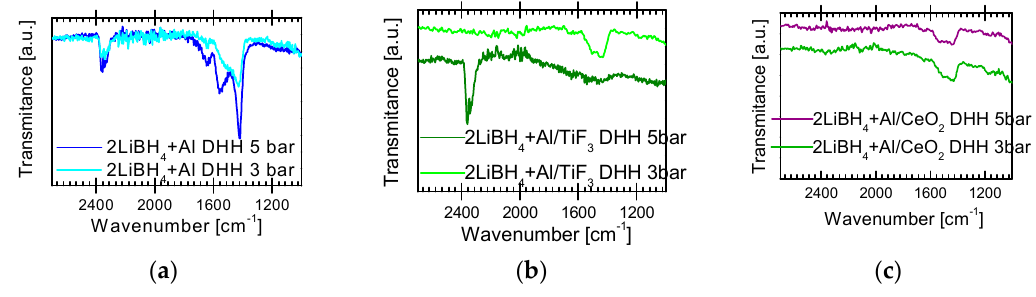
Figure 7. Fourier Transformed Infrared Spectroscopy (FT-IR) of dehydrogenated (DHH) samples: ( a ) 2LiBH 4 + Al-DHH; ( b ) 2LiBH 4 + Al/TiF 3 ; ( c ) 2LiBH 4 + Al/CeO 2 -DHH.